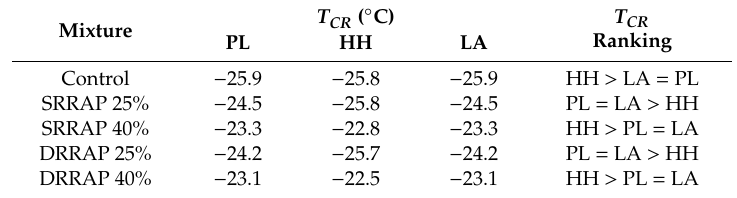
Table 7. Results of T CR ( ◦ C) based on the SAP approach (20 ◦ C /